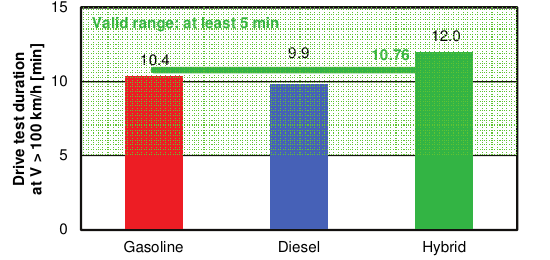
Fig. 9. Comparison of the drive test duration with the limit values (re- quired) and mean values for all vehicles